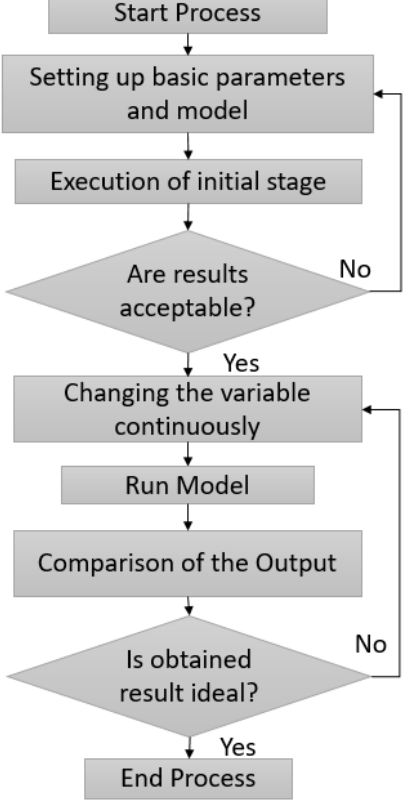
Figure 30. Flow Chart of Simulation of DEM-based model.